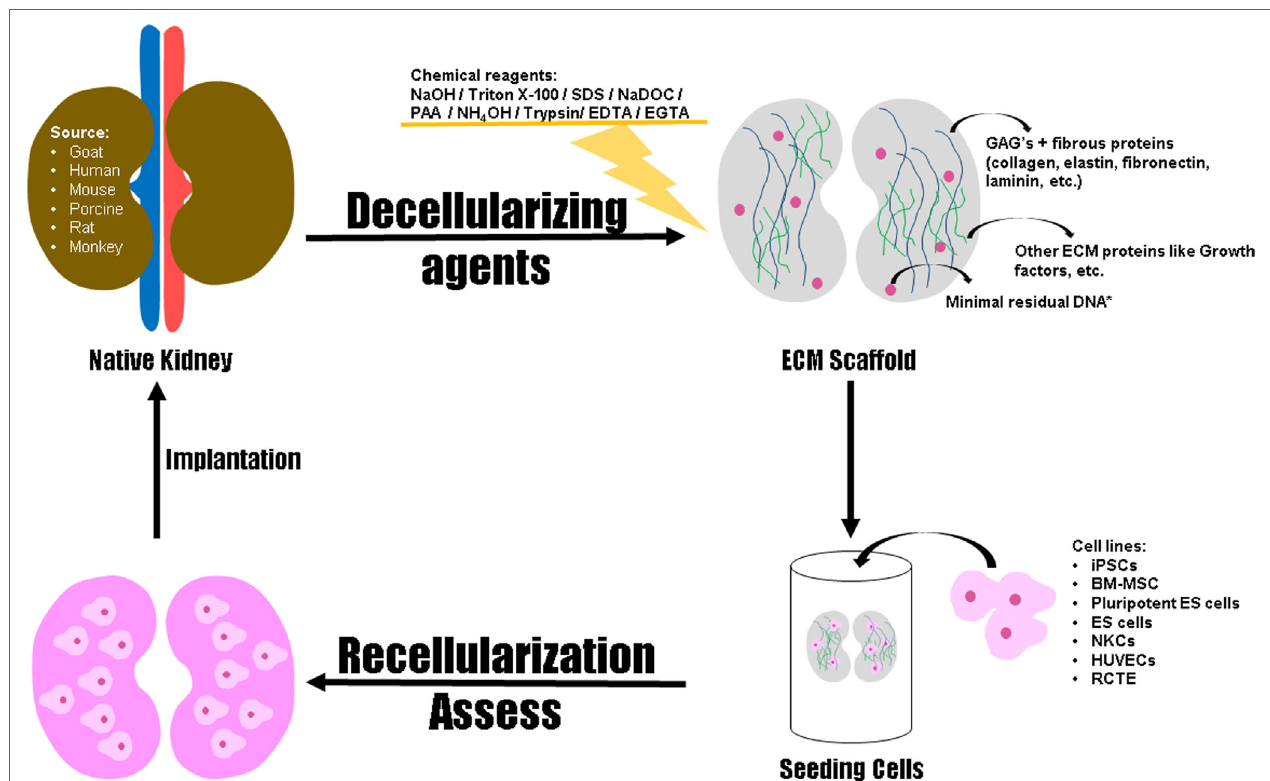
FiGURe 4 | Schematic representation for the development of functional organ by decellularization and recellularization . Native kidneys provided from goat, human, mouse, porcine, rat, and monkey can be decellularized through biological, physical, or chemical methods aiming to obtain a scaffold with preserved structural integrity, retention of ECM proteins and other elements (i.e. growth factors). Regarding the cells types used for repopulation of the scaffold, studies using immortalized human renal cortical-tubular epithelial (RCTE) cell line, human umbilical venous endothelial cells (HUVECs), neonatal kidney cells (NKCs), Embryonic stem (ES) cells, pluripotent ES cells, Bone marrow mesenchymal stem cells (BM-MSCs) and induced pluripotent stem cells (iPSCs) have been driven. The number of adhered cells, the level of cell differentiation, and the functionality of the bioengineered organ must be evaluated for posterior implantation through allotransplantation or xenotransplantation. * Scaffold displaying less than 50 ng of double-stranded DNA per mg of ECM (dry weight) with fragments lower than 200 base pairs